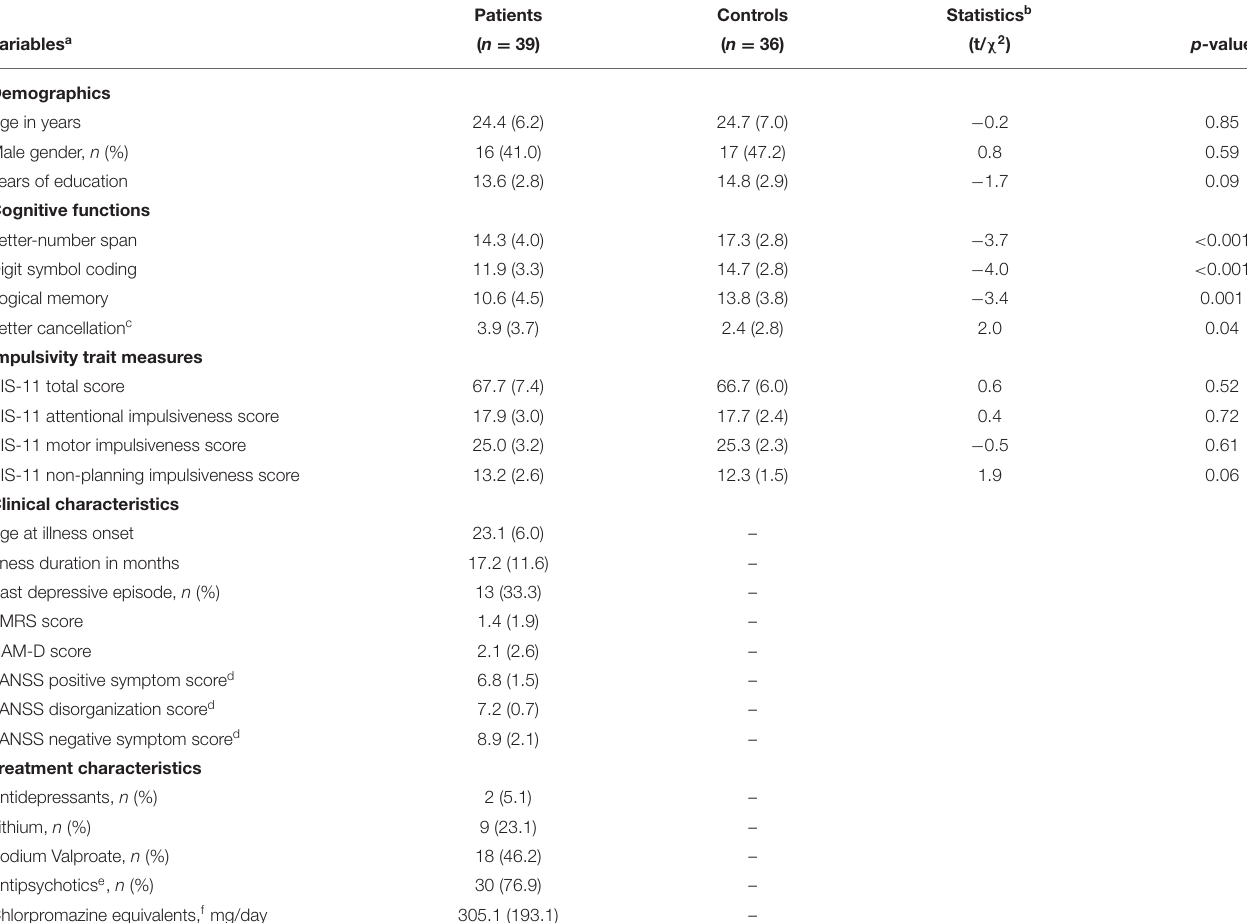
TABLE 1 | Demographics, cognitive functions and clinical characteristics of patients and controls a . Patients